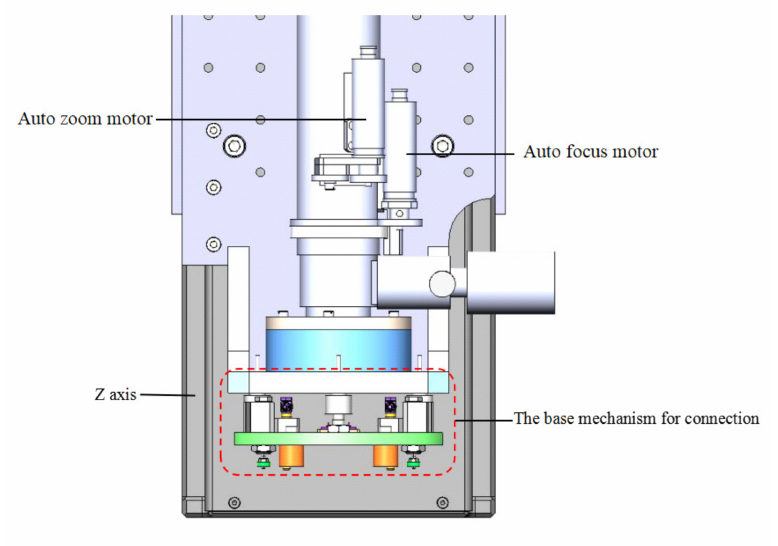
Figure 4. The base mechanism for connection integrated on Z axis.